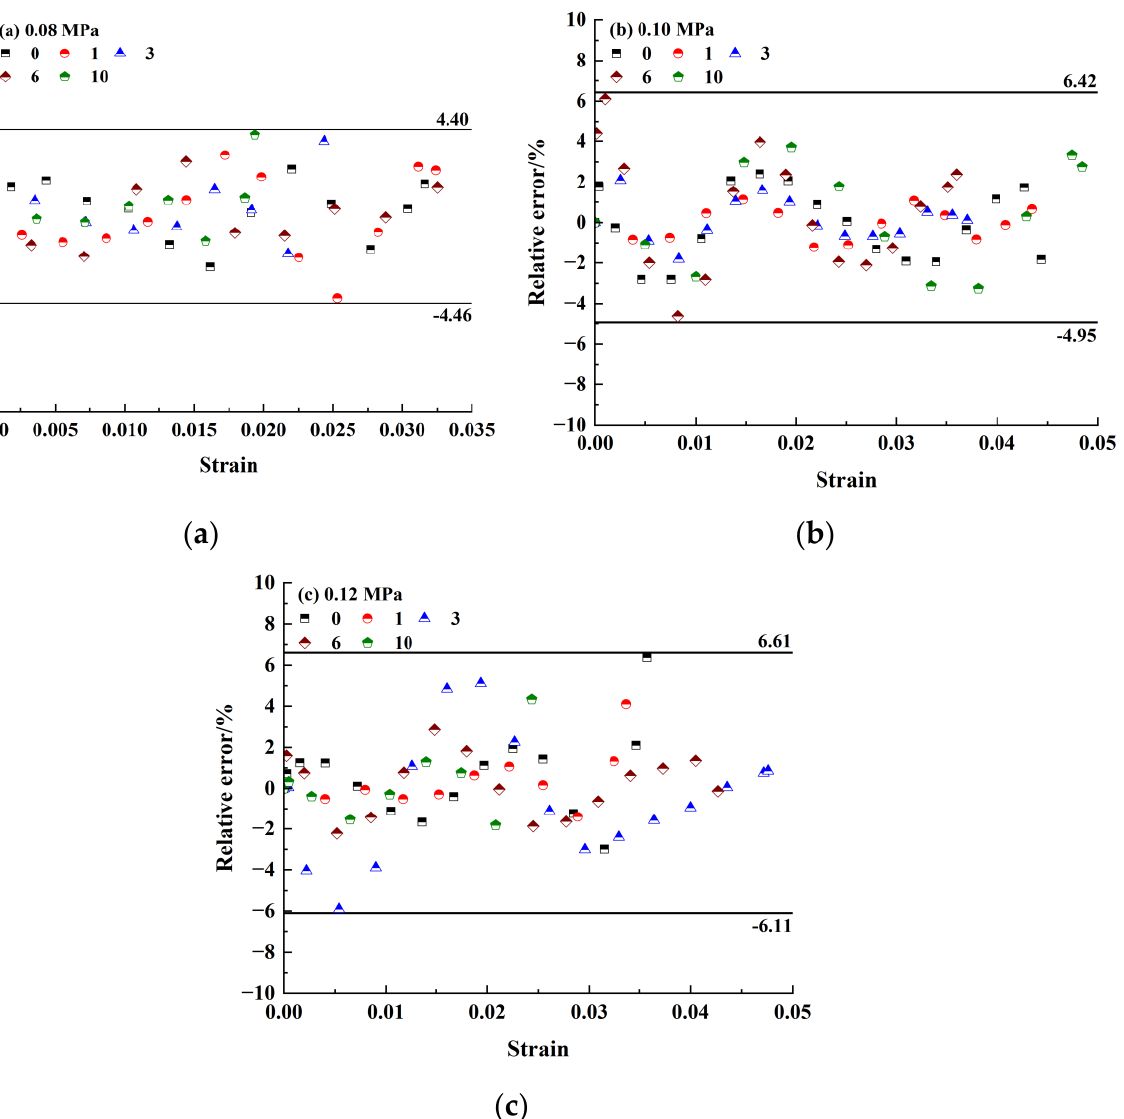
Figure 19. Relative error of cement soils under different test conditions: ( a ) 0.08 MPa; ( b ) 0.10 MPa; ( c ) 0.12 MPa.